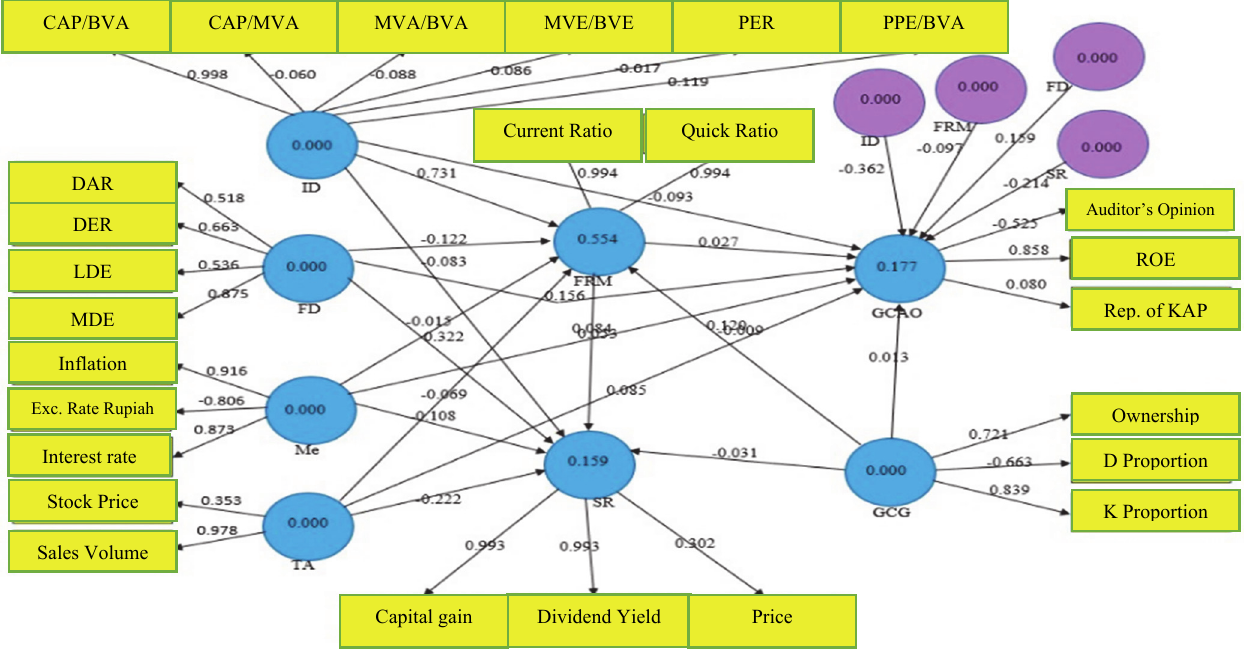
Fig. 1. Initial bootstrapping